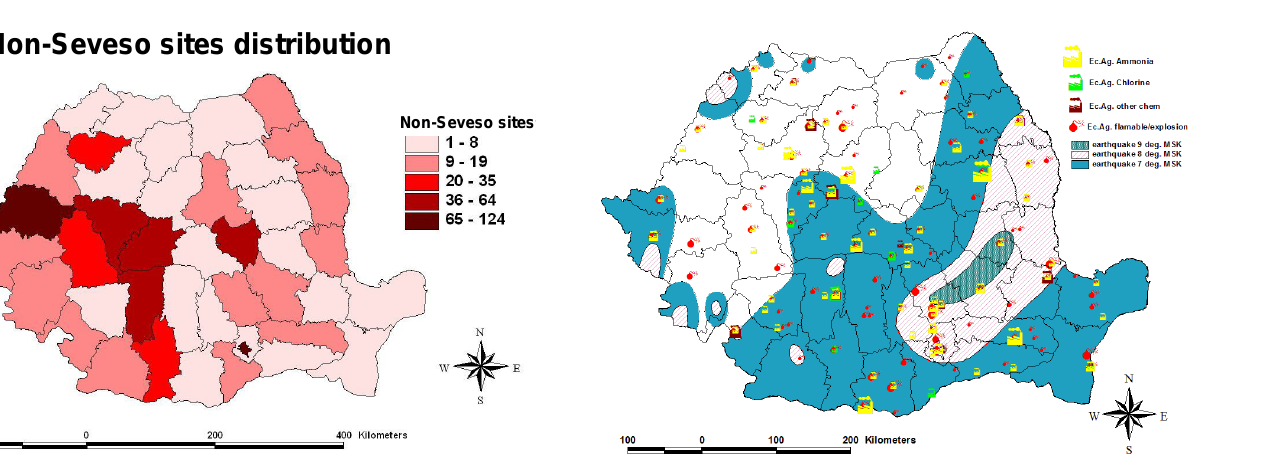
Fig. 3. Non-Seveso sites distribution (2009). Figure 3. Non-Seveso sites distribution (2009) 3